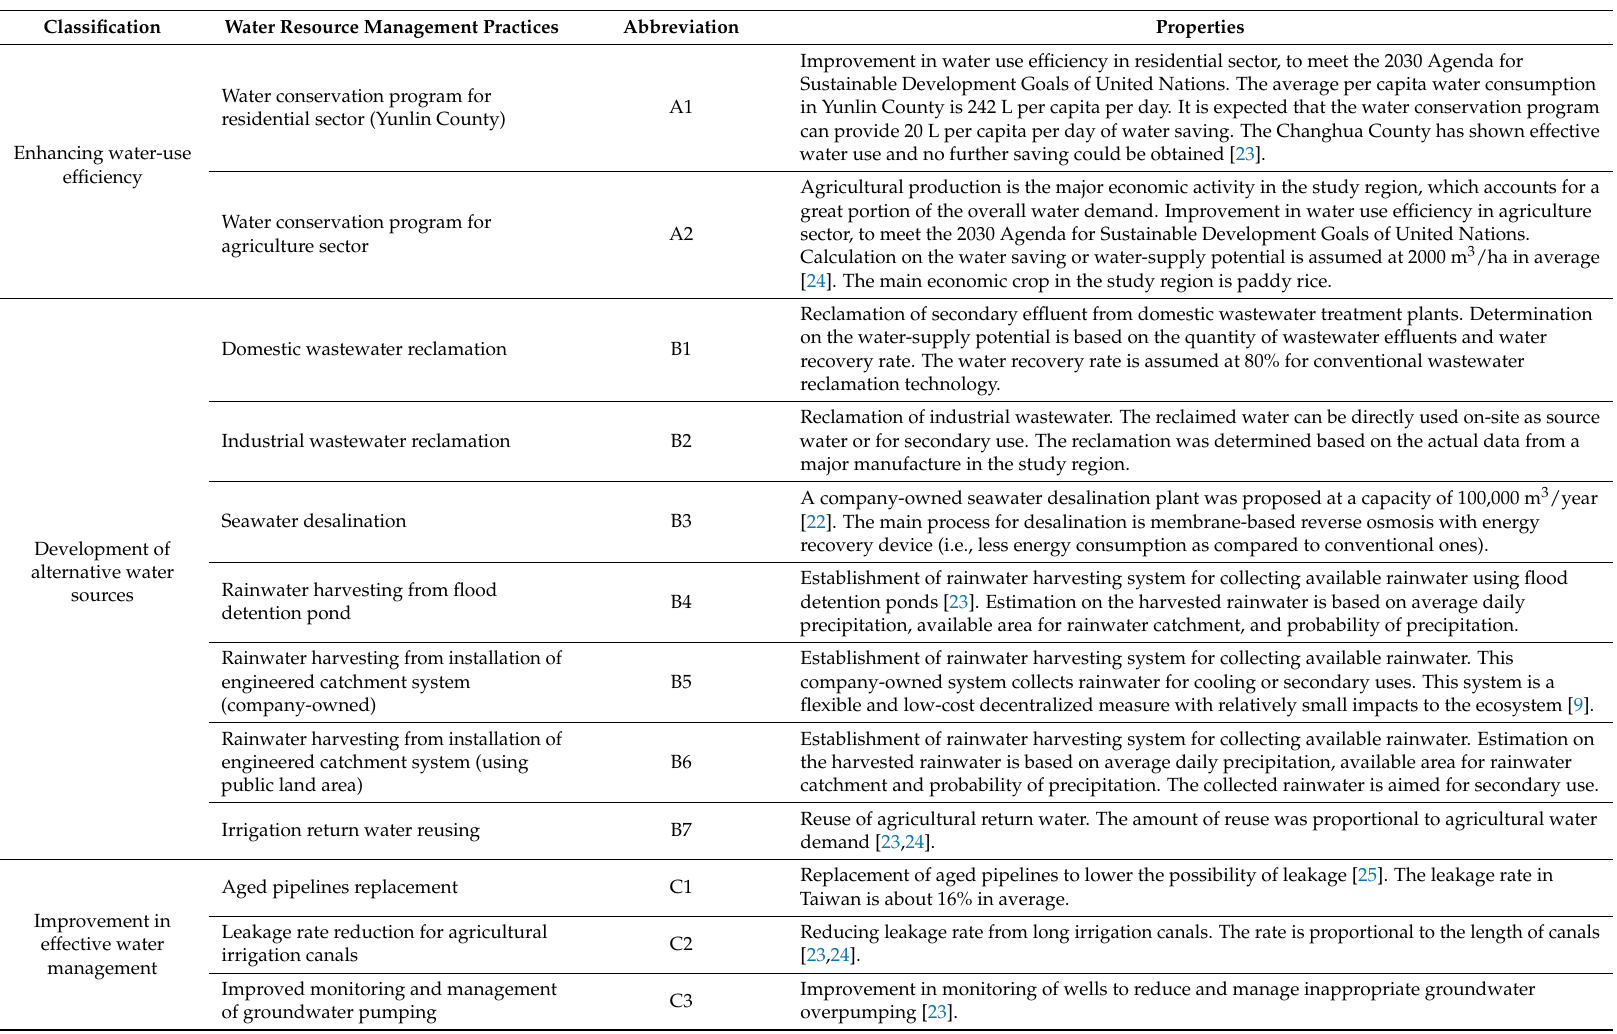
Table 1. Overview of current practices for water resource